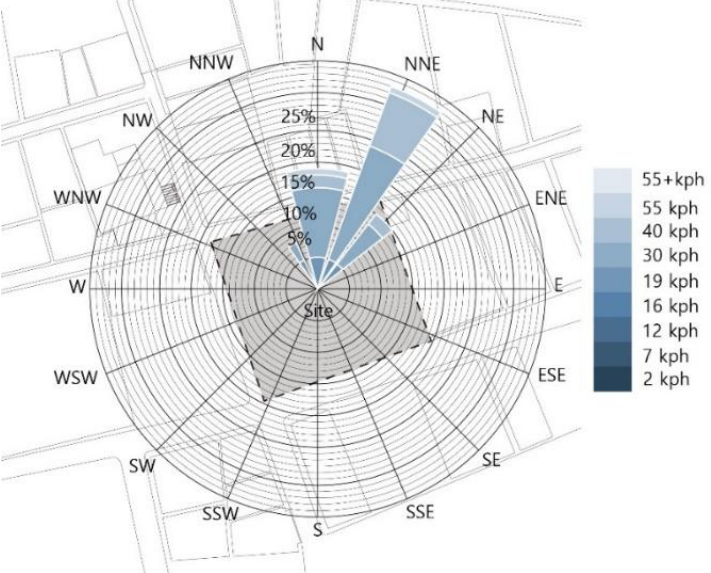
Figure 10. Average annual wind direction and wind rose of the research subject location.